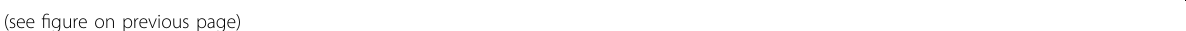
Fig. 4 Binding of transcription factors at distal enhancers of MYB during differentiation. A Public ChIP-seq data were analyzed to show pro fi les of indicated histone modi fi cations and transcription factors in the HBS1L-MYB region in K562 cells. The y axis represents sequence tag density. Genome-wide datasets were obtained from the ENCODE consortium and accessed through the WashU Epigenome Browser. B K562 cells were treated with 30 µM hemin for 72 h, the expression of indicated transcription factors was detected using Western blot. β -actin was used as a loading control. C – G K562 cells were treated with hemin, then the binding of GATA1 ( C ), TAL1 ( D ) C/EBP β ( E ), c-Jun ( F ), and PU.1 ( G ) was detected with ChIP- qPCR at promotor, − 34kb and − 88k regions. H pGL4.10- MYB -promter reporter constructs containing the − 34ka or − 34kb region were transfected into 293T cells with control or GATA1 overexpression, then luciferase activity was determined. Luciferase signals were normalized to renilla signals. I K562 cells were infected with GATA1 overexpressing lentivirus, 72 h after viral infection, MYB and GATA1 expression was detected with Western blot, β -actin was used as a loading control. J K562 cells were infected with lentiviral particles expressing GATA1-shRNA for 72 h, then expression GATA1 and MYB was detected with RT-qPCR. Gapdh was used as an internal control. Data are represented as mean ± SD of three independent experiments, and P values are calculated using Student ’ s t -test (* P < 0.05; ** P < 0.01; *** P < 0.001) in C – H , J